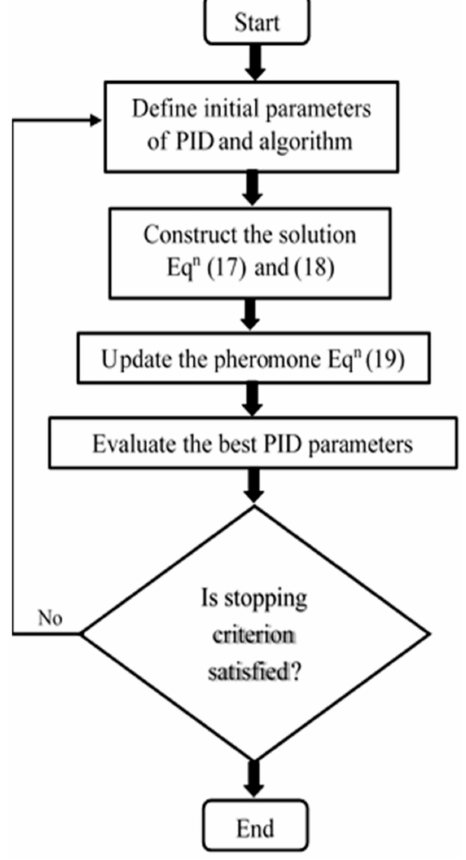
Figure 7. Flow chart of the ACO